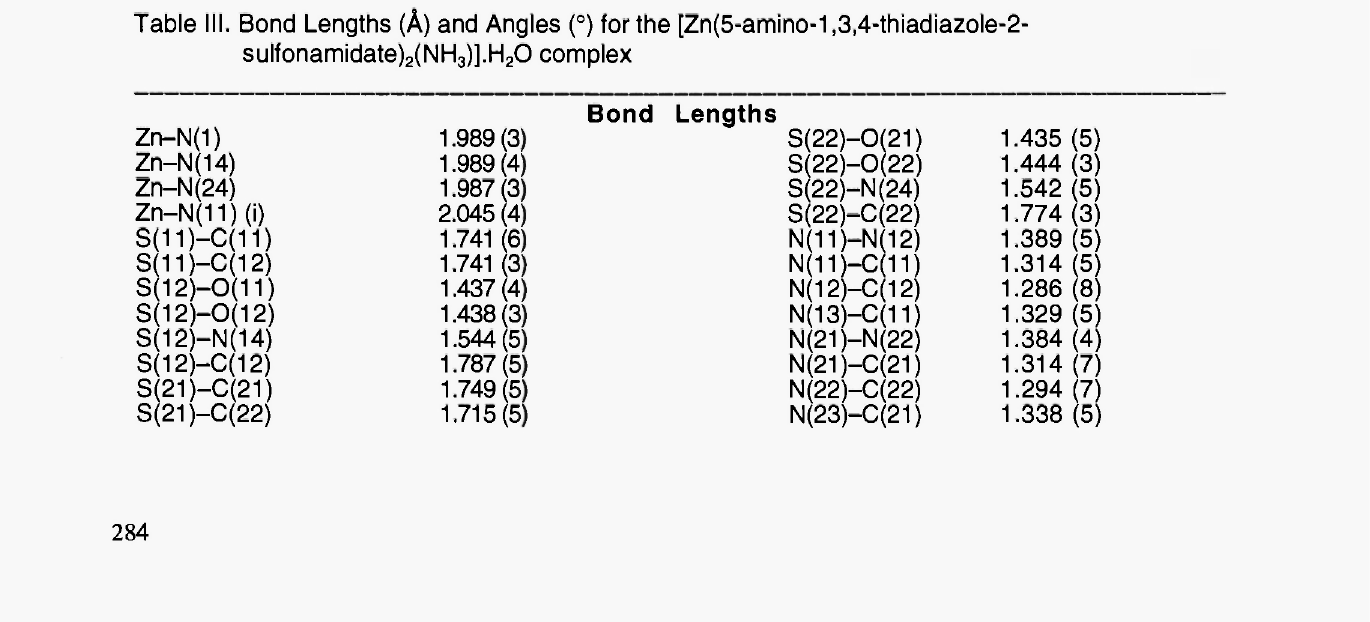
Table III. Bond Lengths (A) and Angles (°) for the